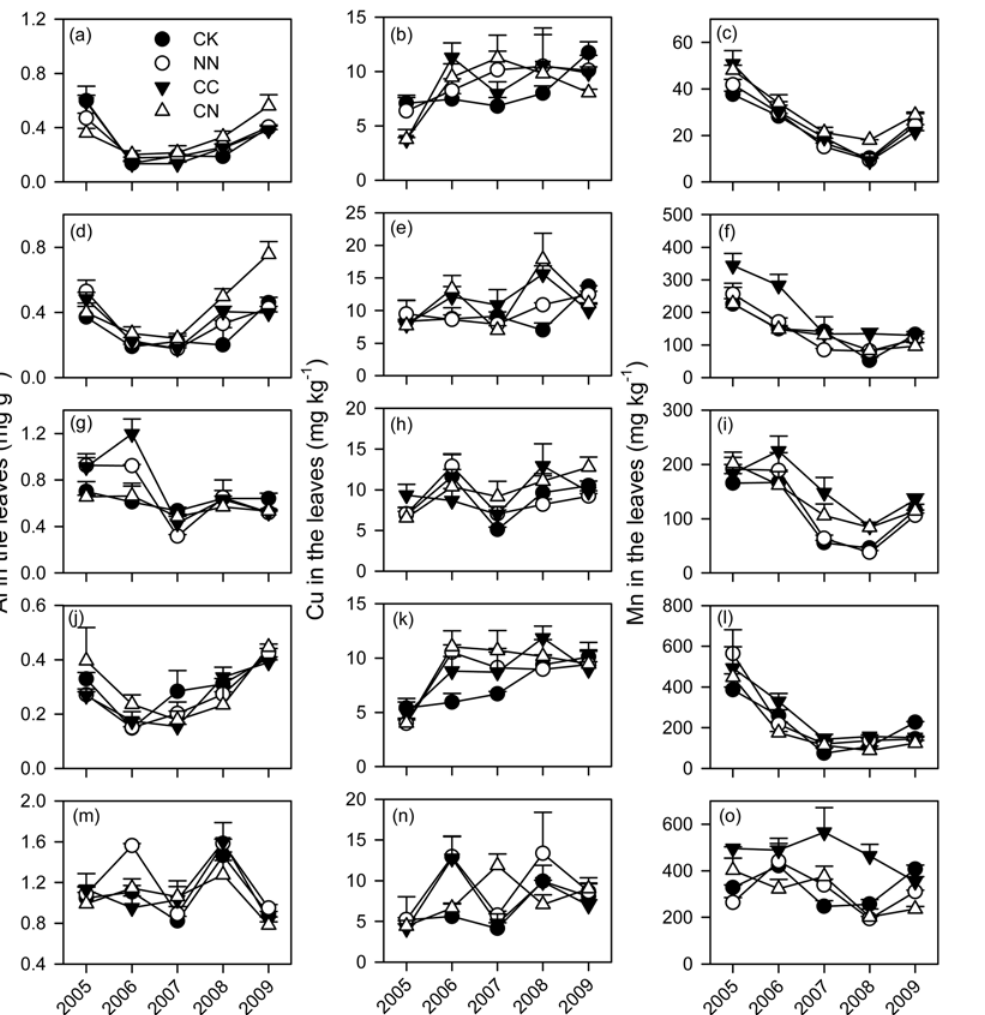
Fig 3. Concentrations of metal cations in the leaves of five subtropical tree species exposed to different CO 2 and N treatments from 2005 to 2009. Each error bar is one standard error. CK, control; NN, ambient CO 2 with N fertilizer; CC, elevated CO 2 without N fertilizer; CN, elevated CO 2 with N